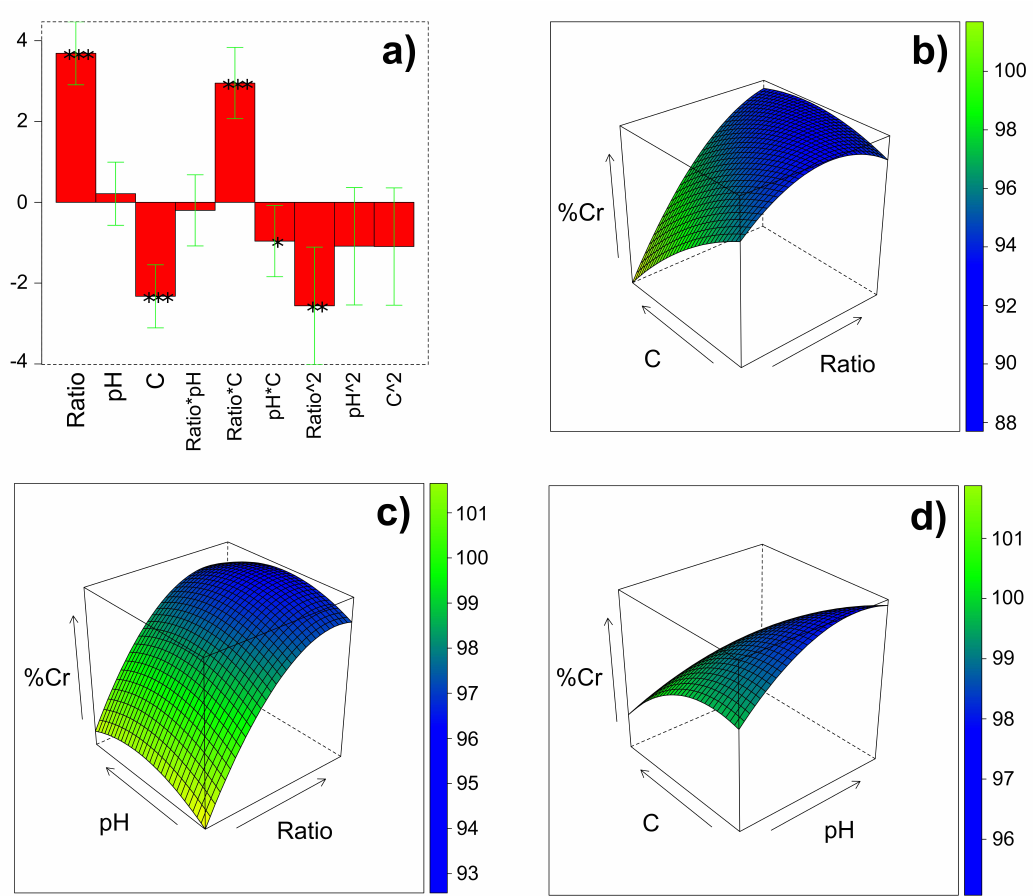
Figure 5. ( a ) Significance of the coefficients. ( b – d ) Response surface plots for binary influence: ( b ) Cr(VI) concentration ratio and LDH mass/solution volume; ( c ) pH ratio and LDH mass/solution volume; ( d ) Cr(VI) concentration and pH (* = 95% confidence level; ** = 99% confidence level; *** = 99.9% confidence